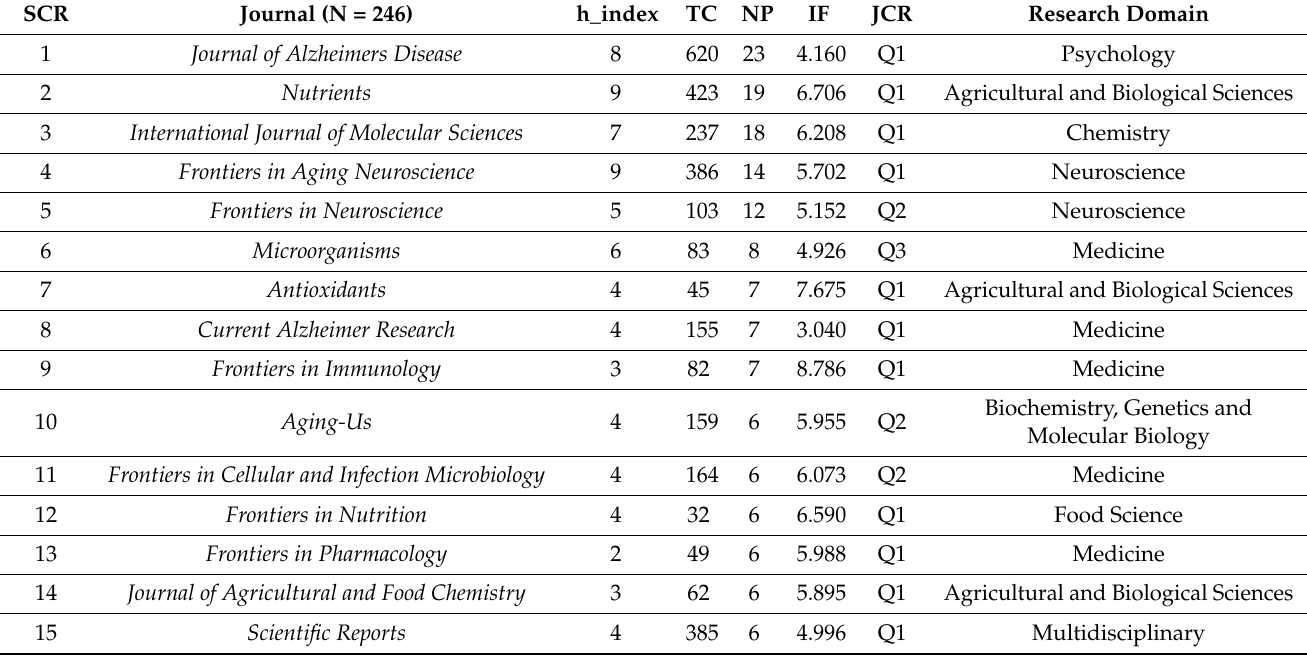
Table 2. Top 15 most cited journal contributed to microbiome–gut–brain axis and dementia related research.